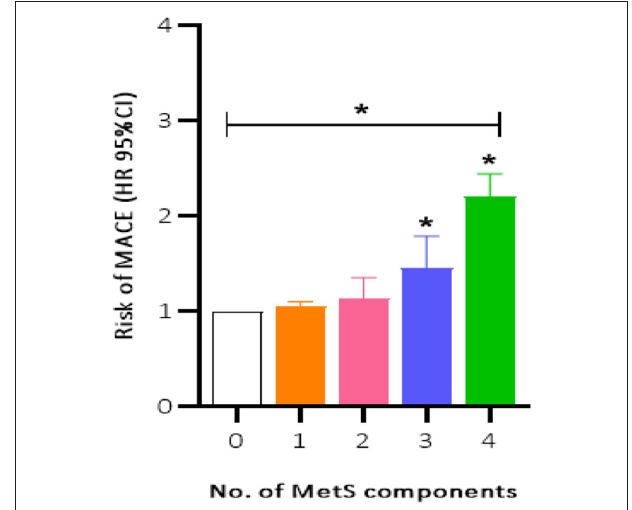
FIGURE 2 | Incidence risk of MACE (HR 95% CI) by the number of the MetS components present in patients, P for trend = 0.045. MACE, major adverse cardiovascular event; MetS, metabolic syndrome. * P < 0.05.